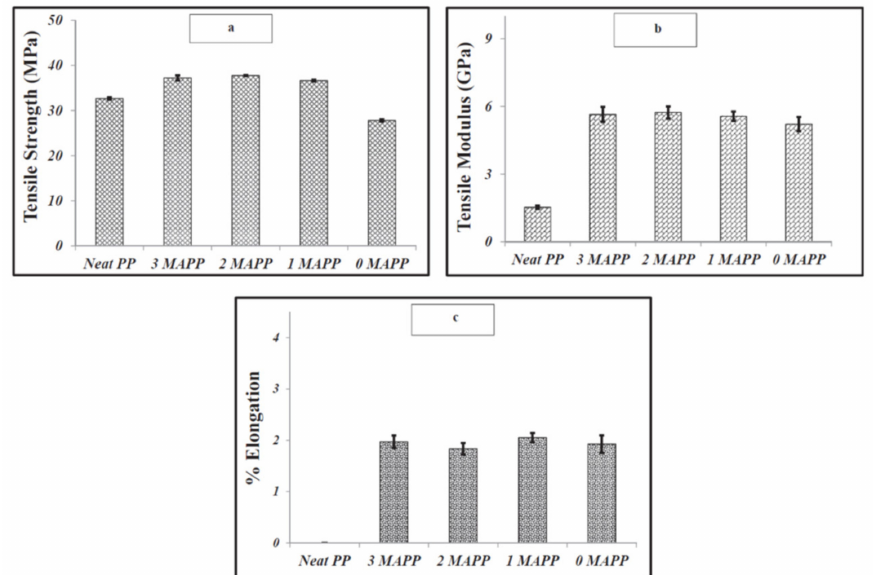
Figure 4. The figures here show the mechanical properties of biochar filled polypropylene composites ( a ) Tensile strength, ( b ) tensile modulus and ( c ) percentage elongation. Figure is taken from [42] with permission to reuse from Elsevier Publications